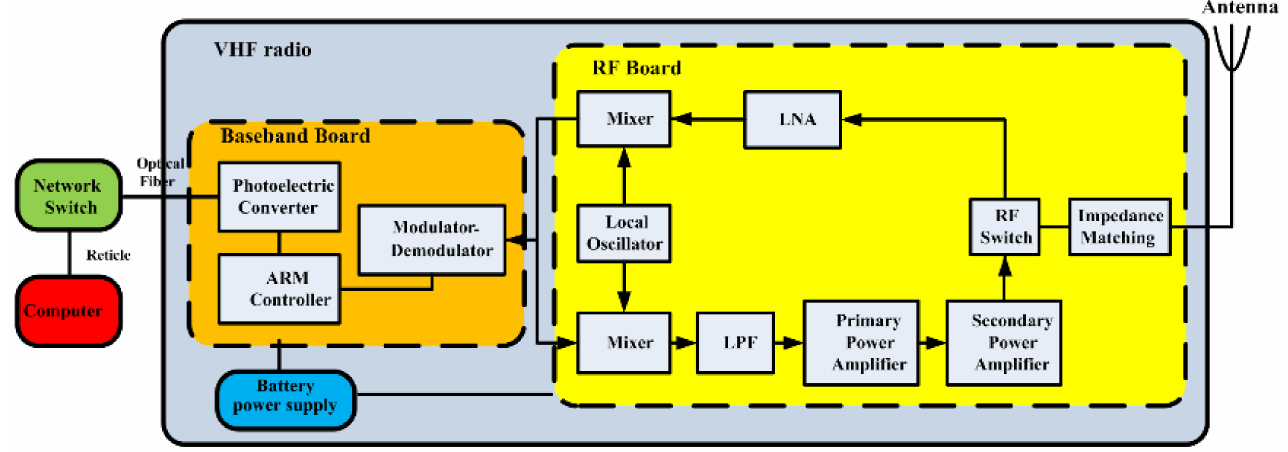
Figure 1. Diagram of electronic system with VHF